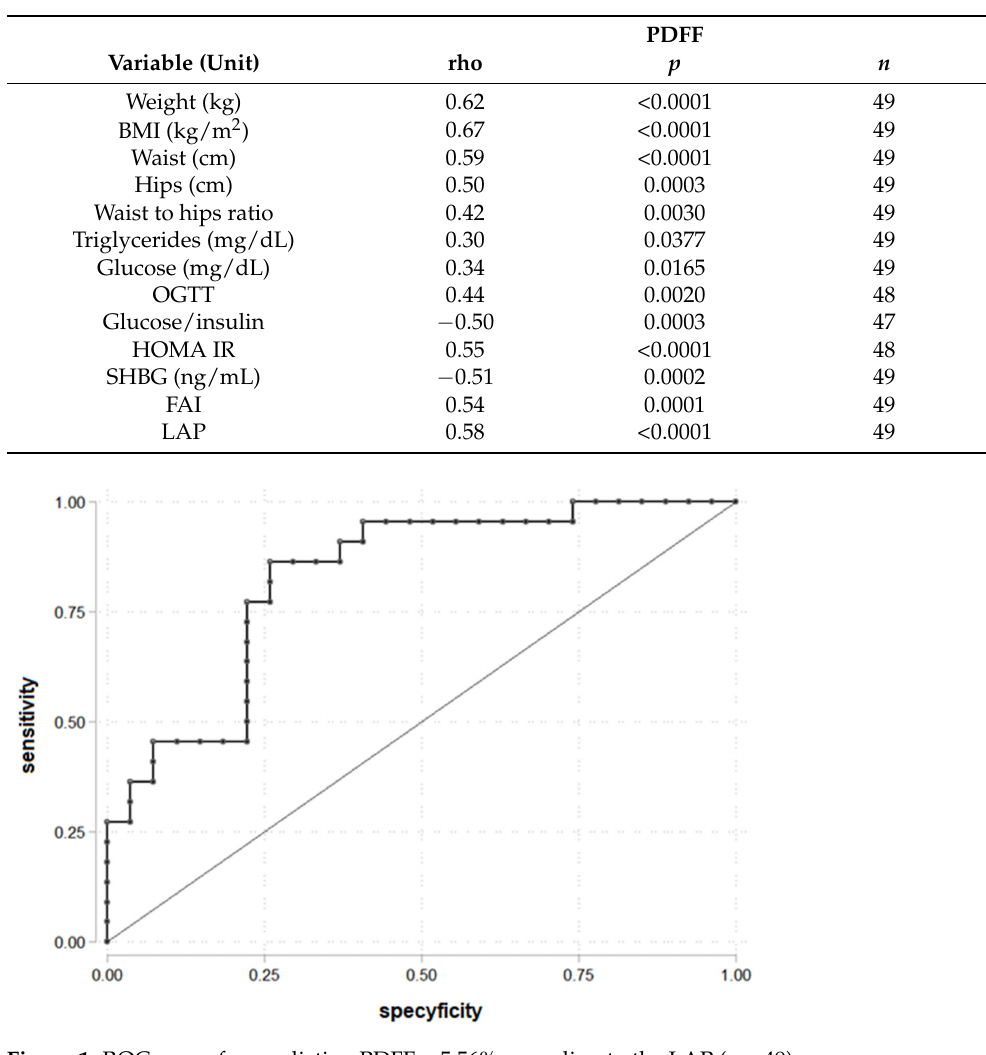
Figure 1. ROC curve for prediction PDFF > 5.56% according to the LAP ( n = 49). Table 3. The number of patients with liver steatosis depending on